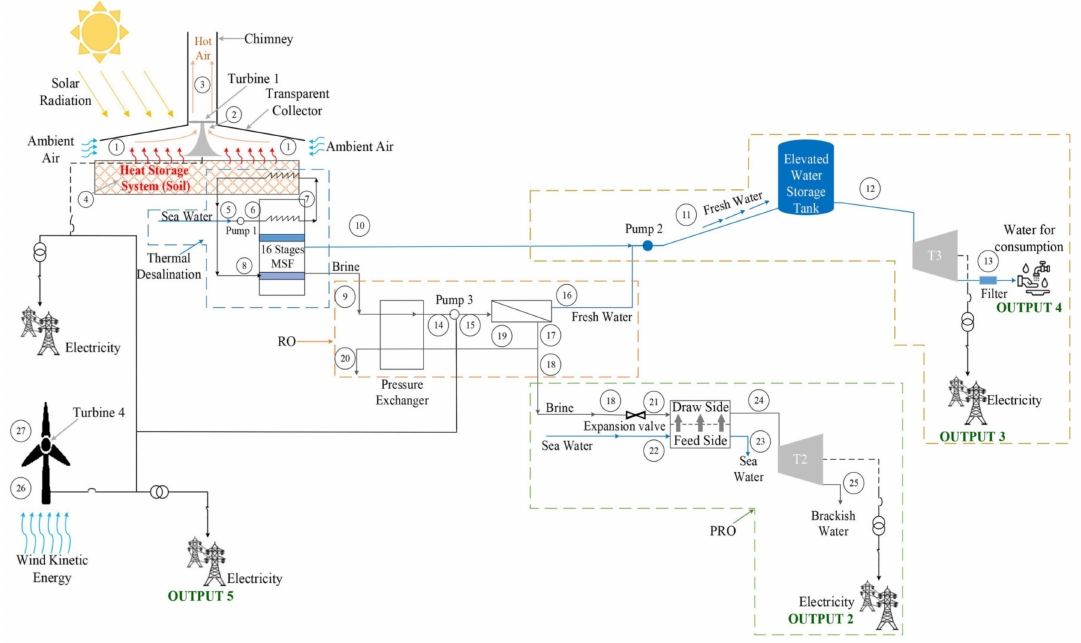
Figure 10. Representation of the hybrid MSF-RO system powered by solar energy using a solar chimney and wind energy. Taken from